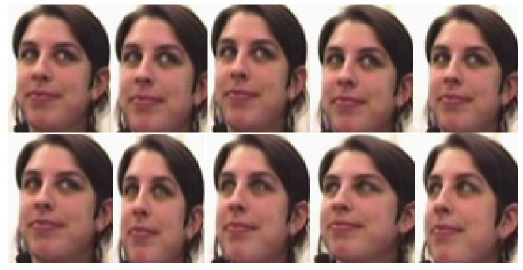
Fig.1. Face images of AMIES2016 database